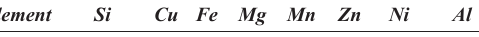
Table 1. Composition of the A413.1 aluminium alloy (wt.%) (according to the manufacturer). Element